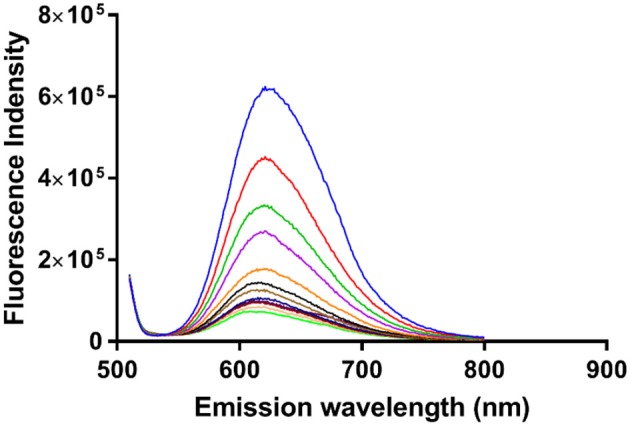
The luminescence decrease of α-Me4phen-bb7 upon the addition of Q[10] to a Q[10] to α-Me4phen-7 ratio of 1.5.